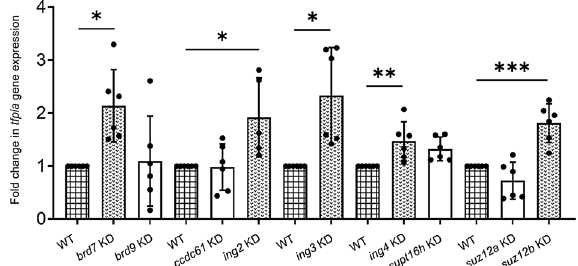
Figure 2. Levels of tfpia mRNA in a secondary knockdown screen of chromatin binding and regulatory proteins. Quantitative real-time PCR showing the fold change of tfpia gene expression in liver and spleen in knockdown of 9 chromatin binding and regulatory protein genes, brd7 , brd9 , ccdc61 , ing2 , ing3, ing4, supt16h, suz12a, and suz12b , with daily wild-type (WT) controls using one-way ANOVA. The bar graphs represent daily wild-type controls (squared bars), and all knockdowns (open bars and dotted bars) to the right of each wild-type were performed on the same day. Error bars represent mean ± SD. Six fish were used for each of the chromatin binding and regulatory protein gene knockdown and control experiments (N = 6). The lines on the top represent a significant difference between wild-type and knockdown samples. *, **, and *** represent p ≤ 0.05, p ≤ 0.01, and p ≤ 0.001, respectively. p-value < 0.05 was considered